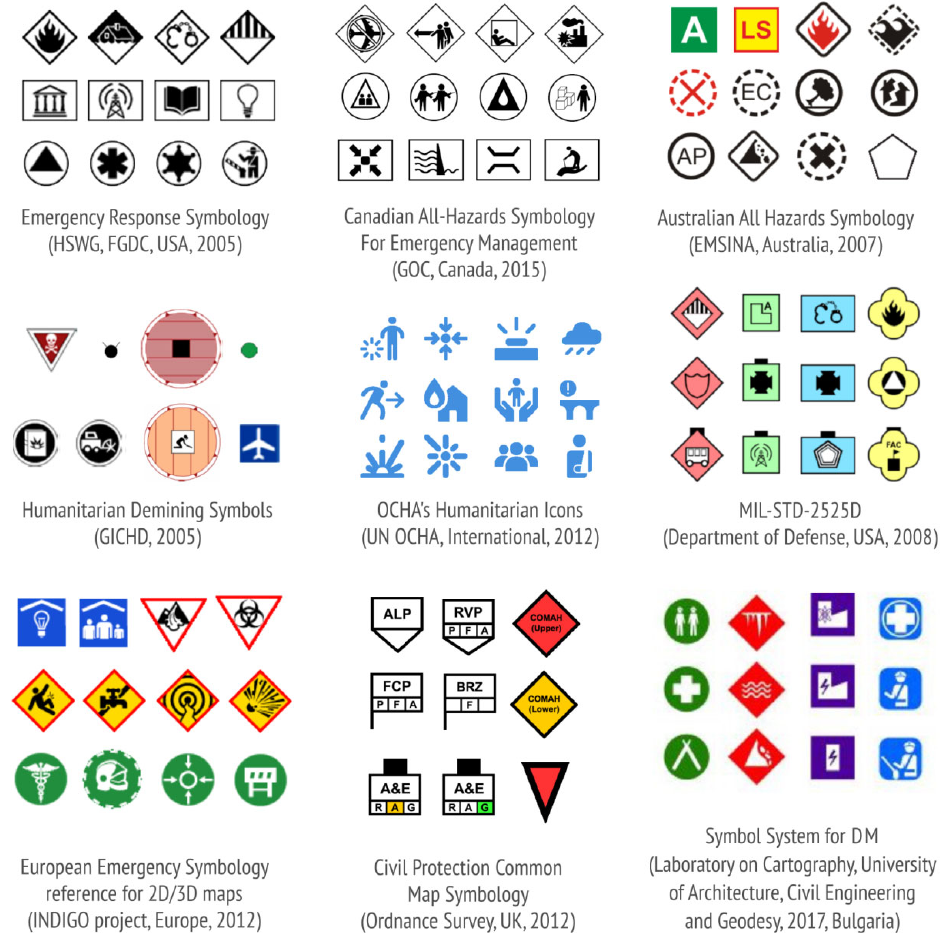
Figure 1. Examples of cartographic symbology for crisis mapping.